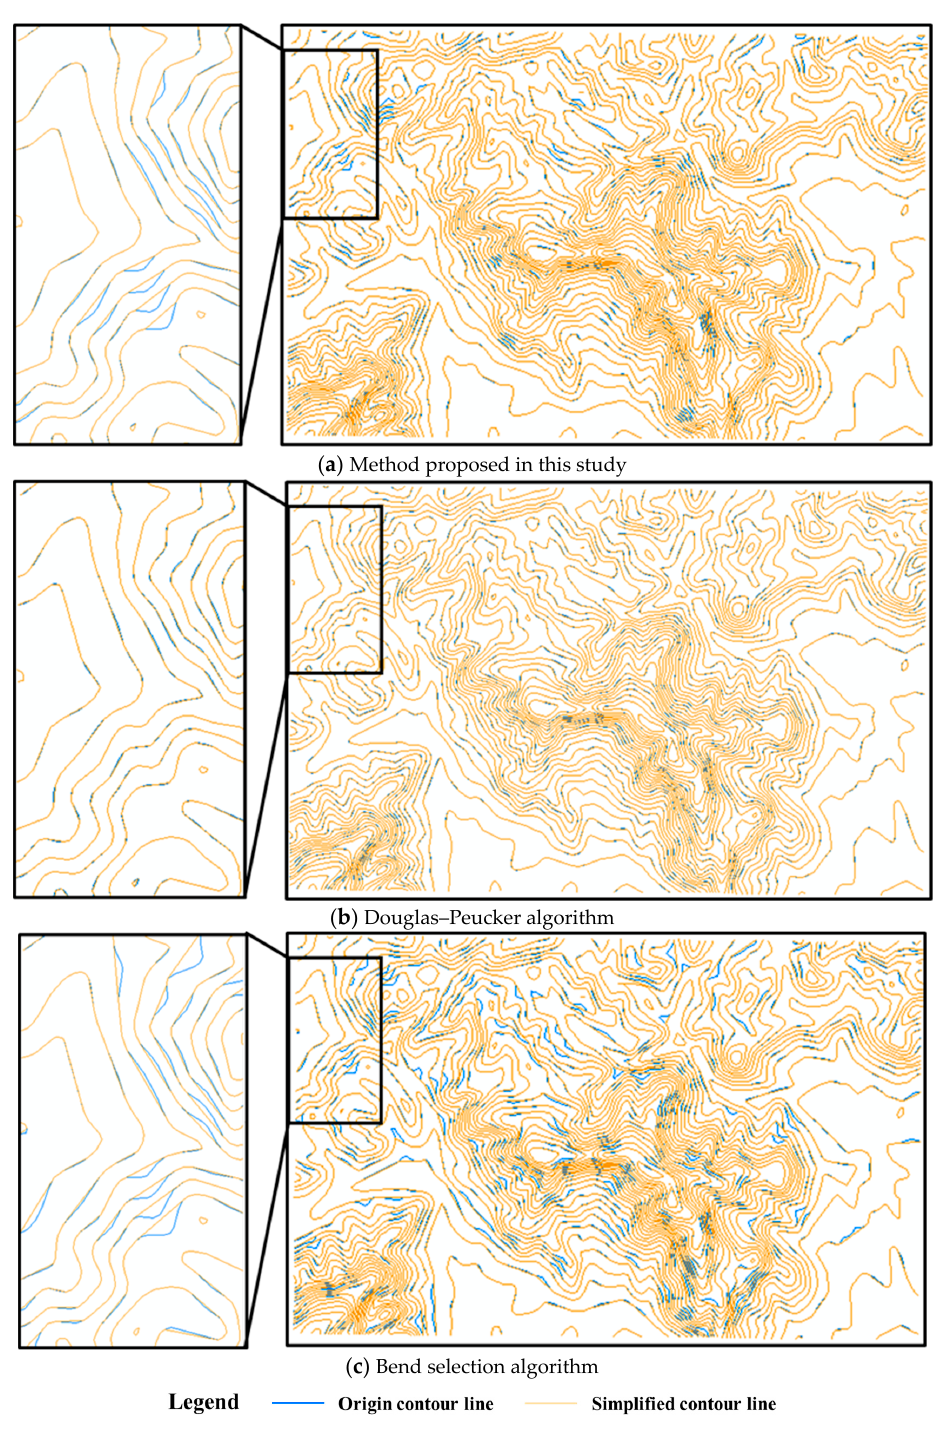
Figure 14. Contour line simplification results. Three indicators were used to quantitatively assess the results of the three algorithms: point compression, horizontal deviation, and visible valley bend reduction (Table 1). Higher point compression [11] equated to a higher degree of simplification. Horizontal